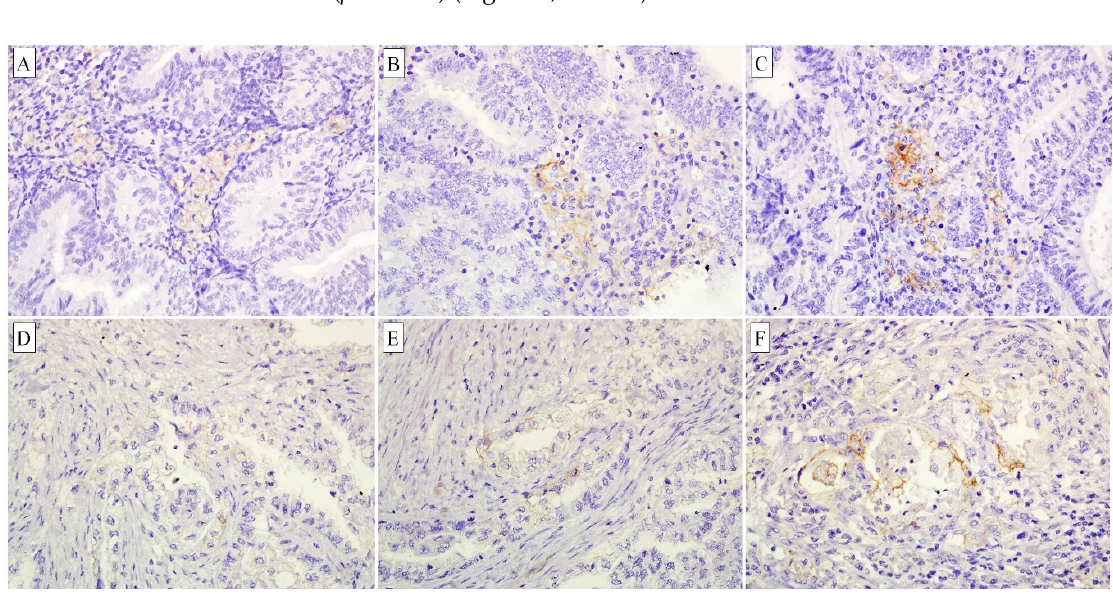
Figure 1. PD-L1 immunohistochemistry showed membranous staining. ( A ) Strong PD-L1 staining in immune cells of tonsils (control; 200×); ( B ) Negative PD-L1 staining in normal endometrium (200×).